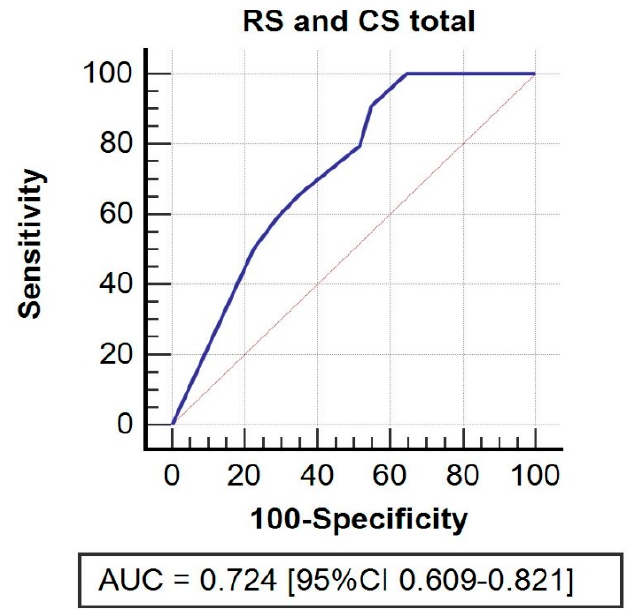
Figure 4. ROC curve. Receiver operating characteristic (ROC) curve for residual shortening and its impact on total CS.